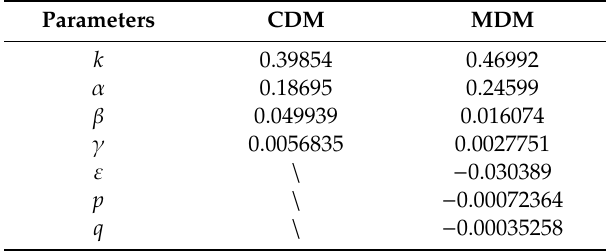
Table 2. Identified parameters of CDM and modified Duhem model